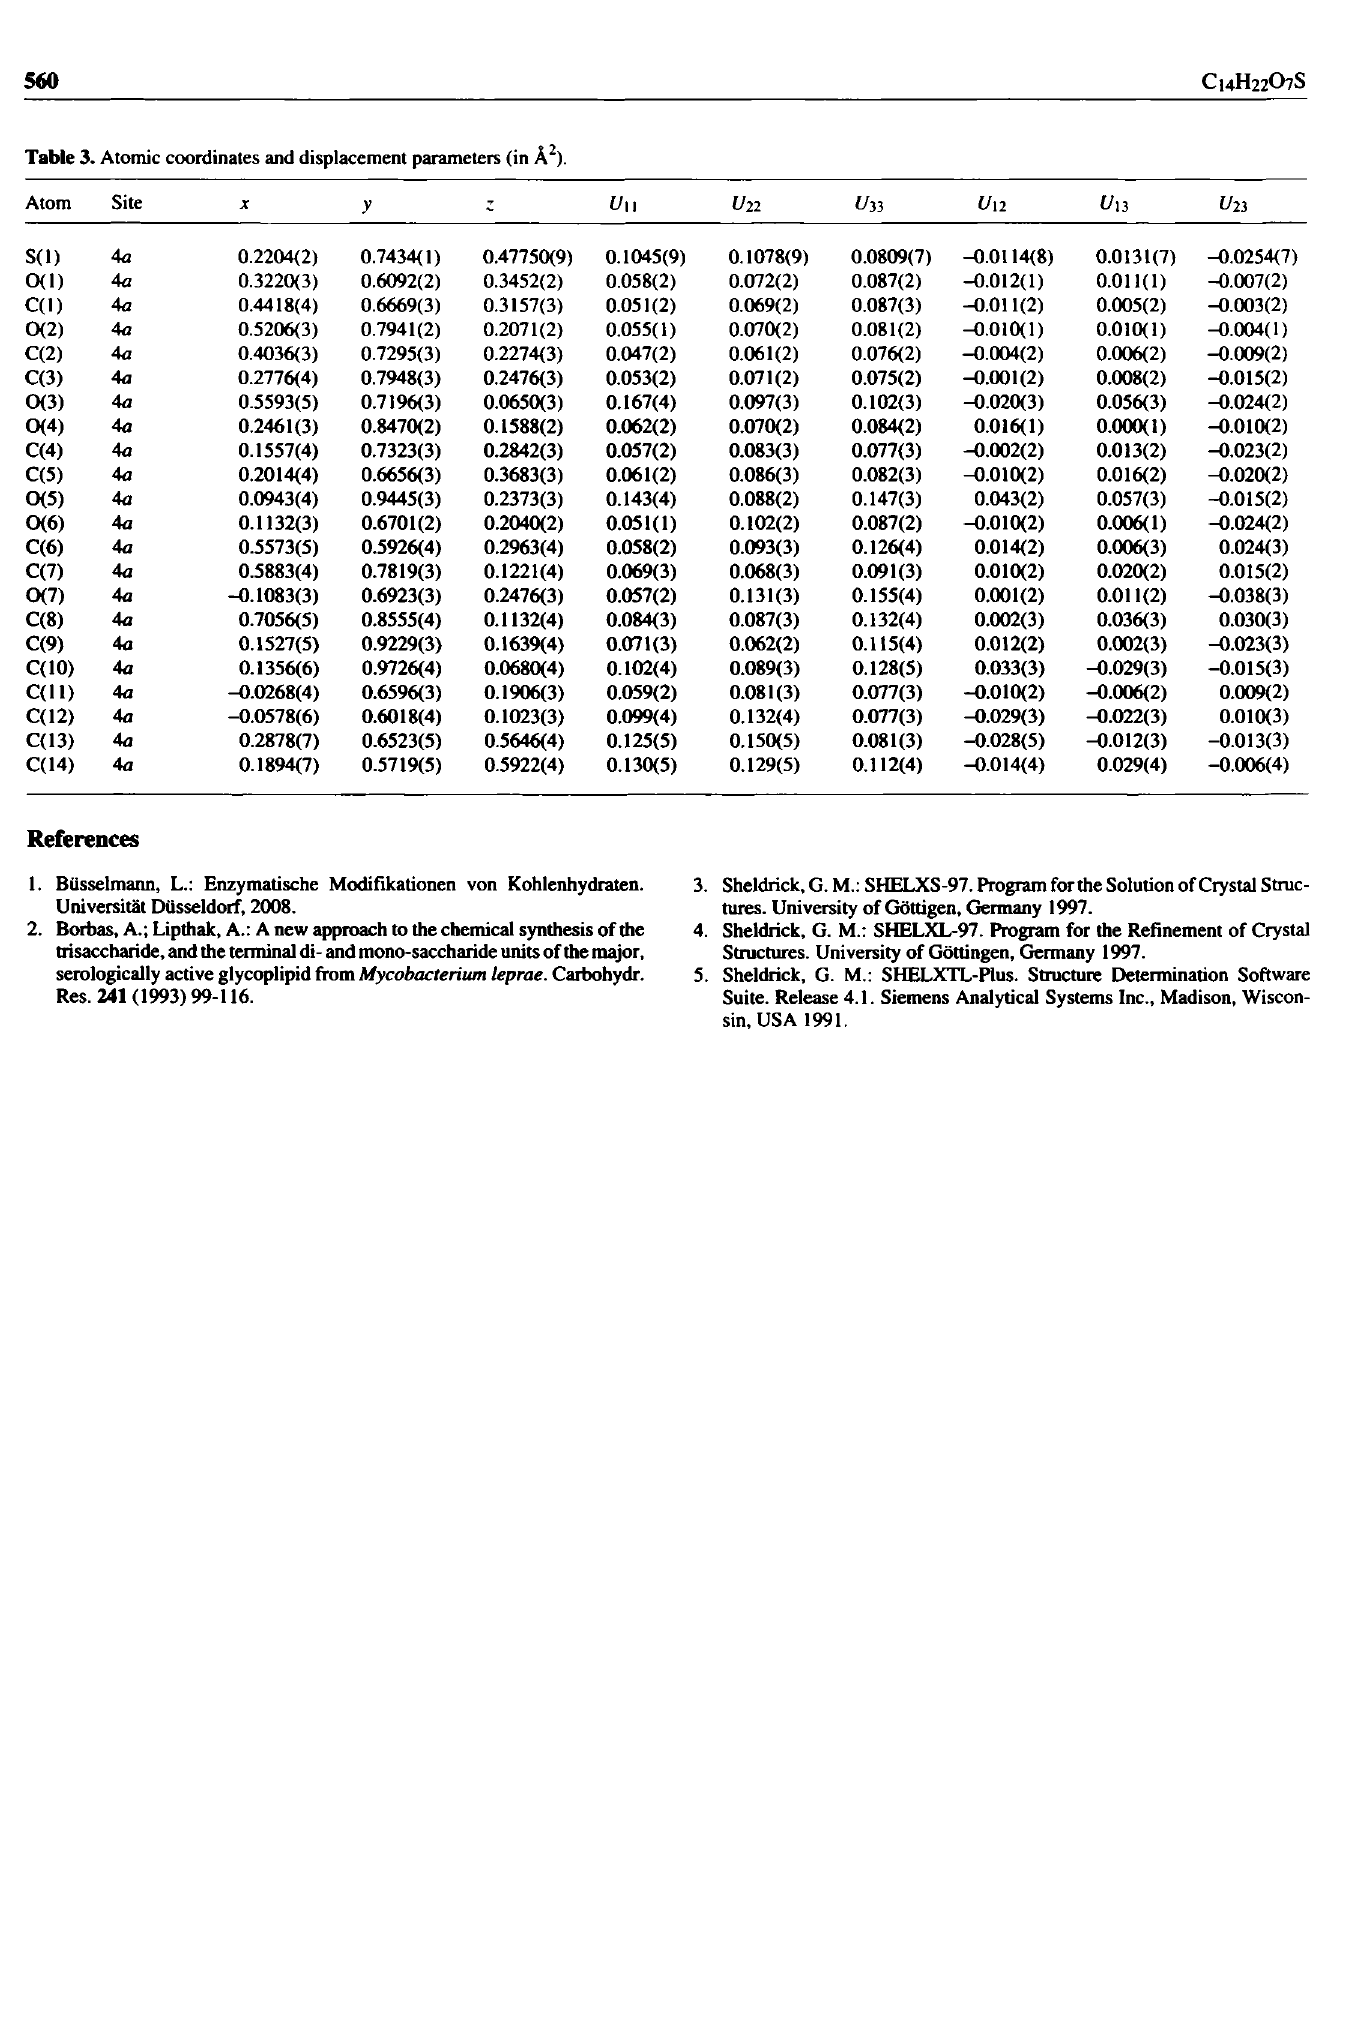
Table 3. Atomic coordinates and displacement parameters (in Â 2